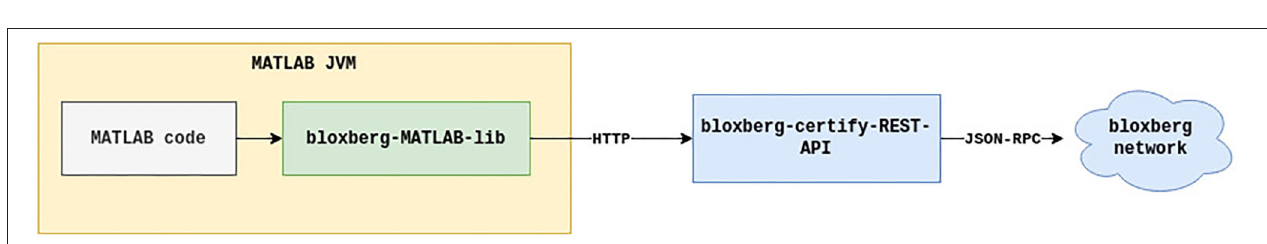
FIGURE 2 | Components, relations, and